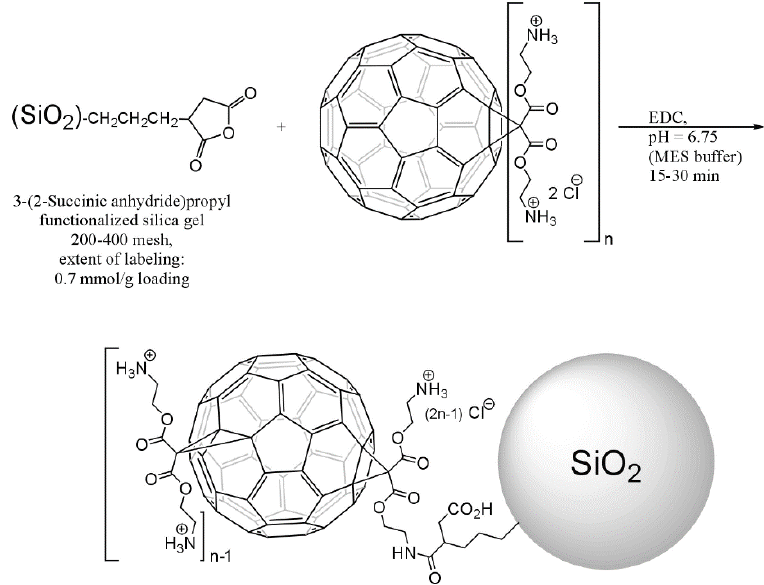
Figure 9. Route for immobilization of aminofullerenes on functionalized silica gel. Reproduced with permission from Reference [140]. Copyright 2010, ACS.